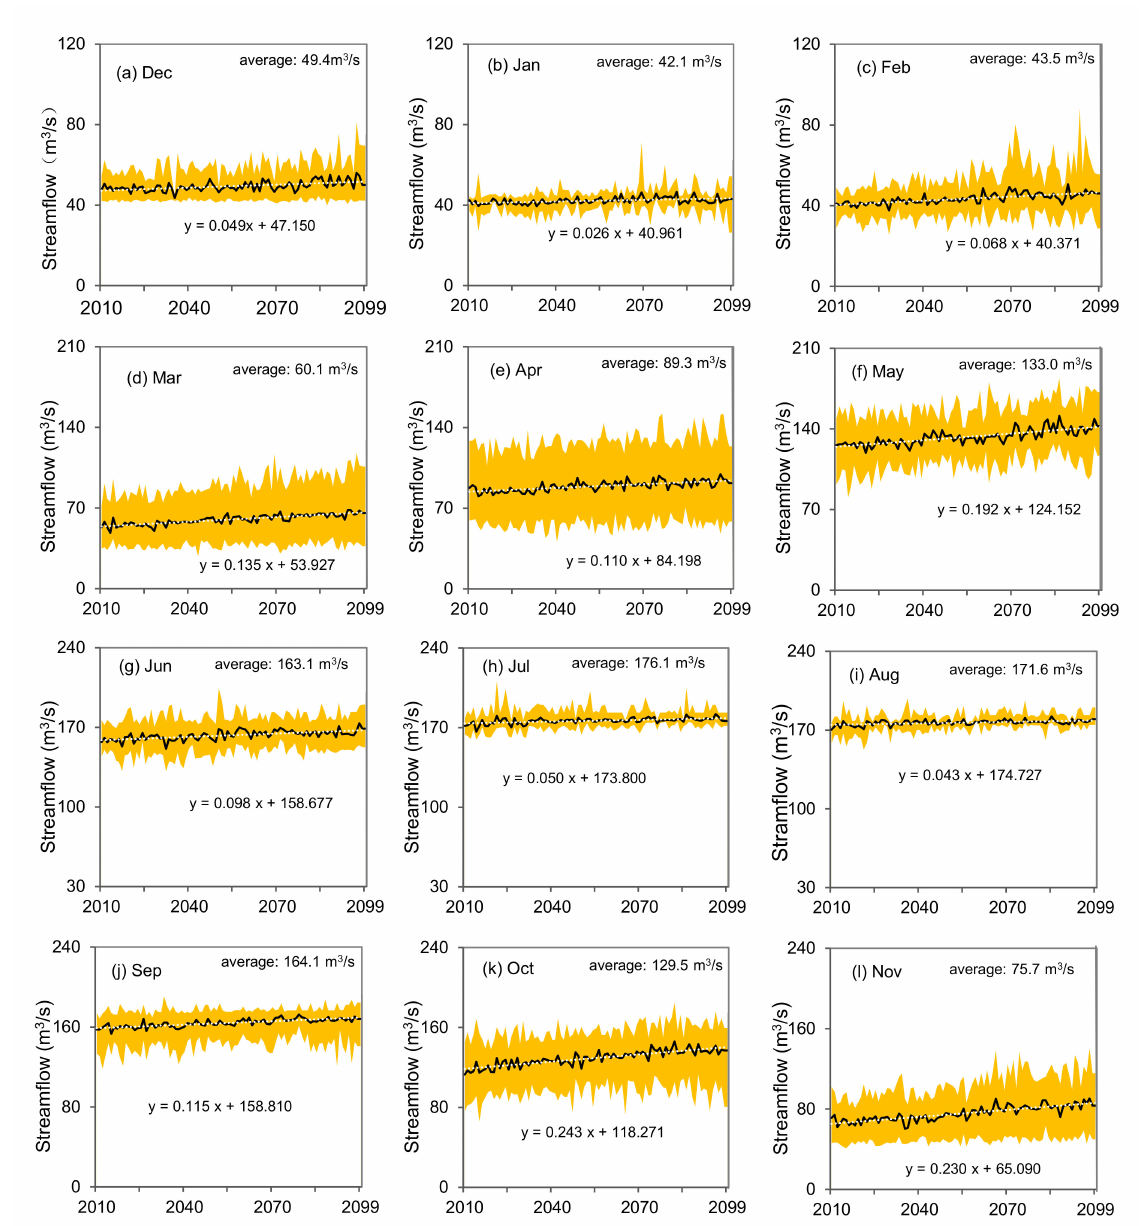
Figure 8. Monthly streamflow during the period 2010–2099 (the orange color is the range of streamflow, the black line is the average streamflow, and the white dotted line is the trending